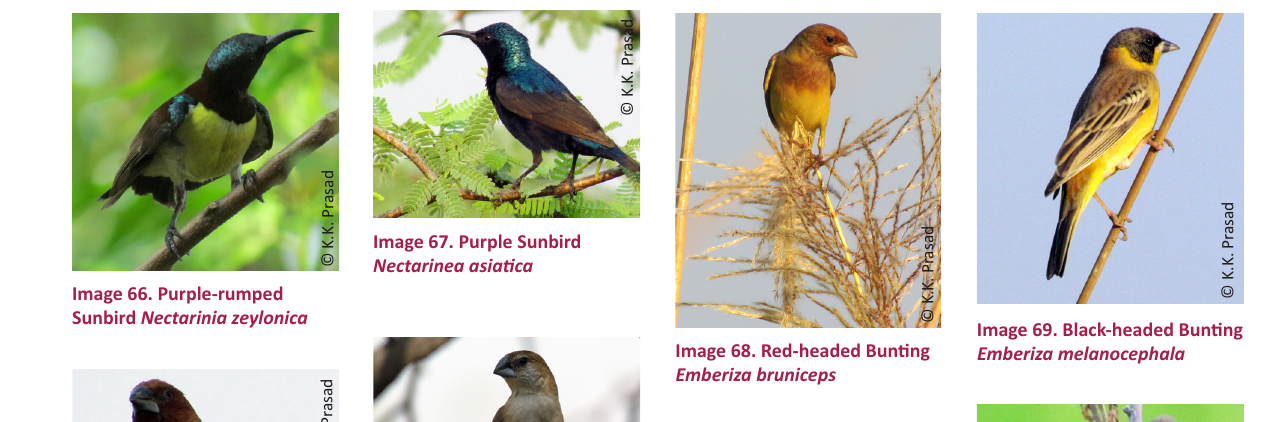
Image 68. Red-headed Bunting Emberiza bruniceps